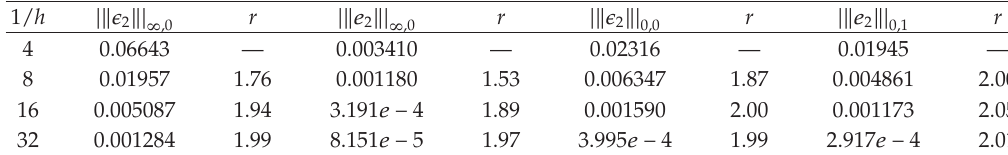
Table 2: Correction step approximation for λ (cid:9) 5 .